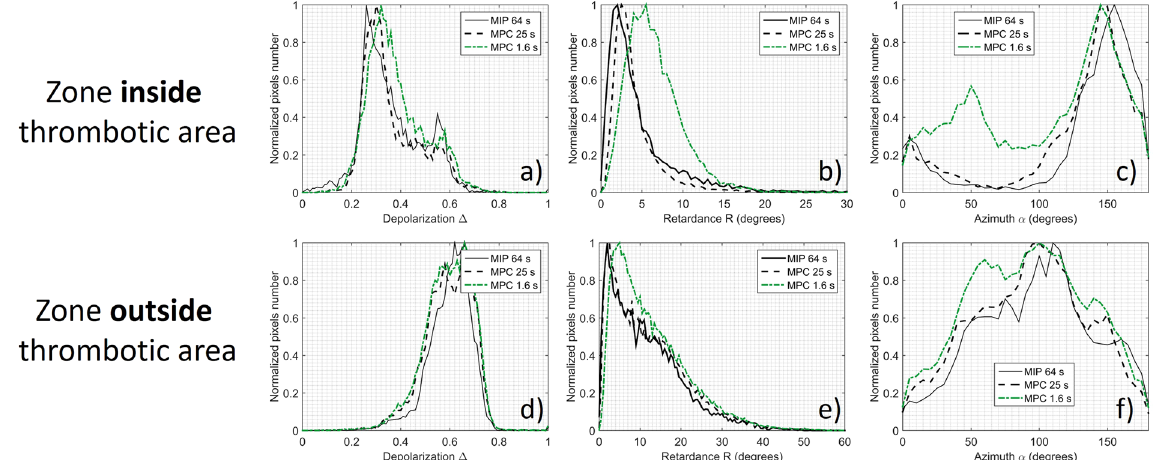
Figure 4. Comparison between histograms of Depolarization, Retardance and Azimuth measured with the MIP in 64 s (reference), with the MPC in 25 s and with the MPC in 1.6 s for the zone selected around the thrombotic zone (delineated by the orange dotted line in Fig. 3(i)) and the zone selected outside the thrombotic region (delineated by the white dotted line in Fig. 3(i)).